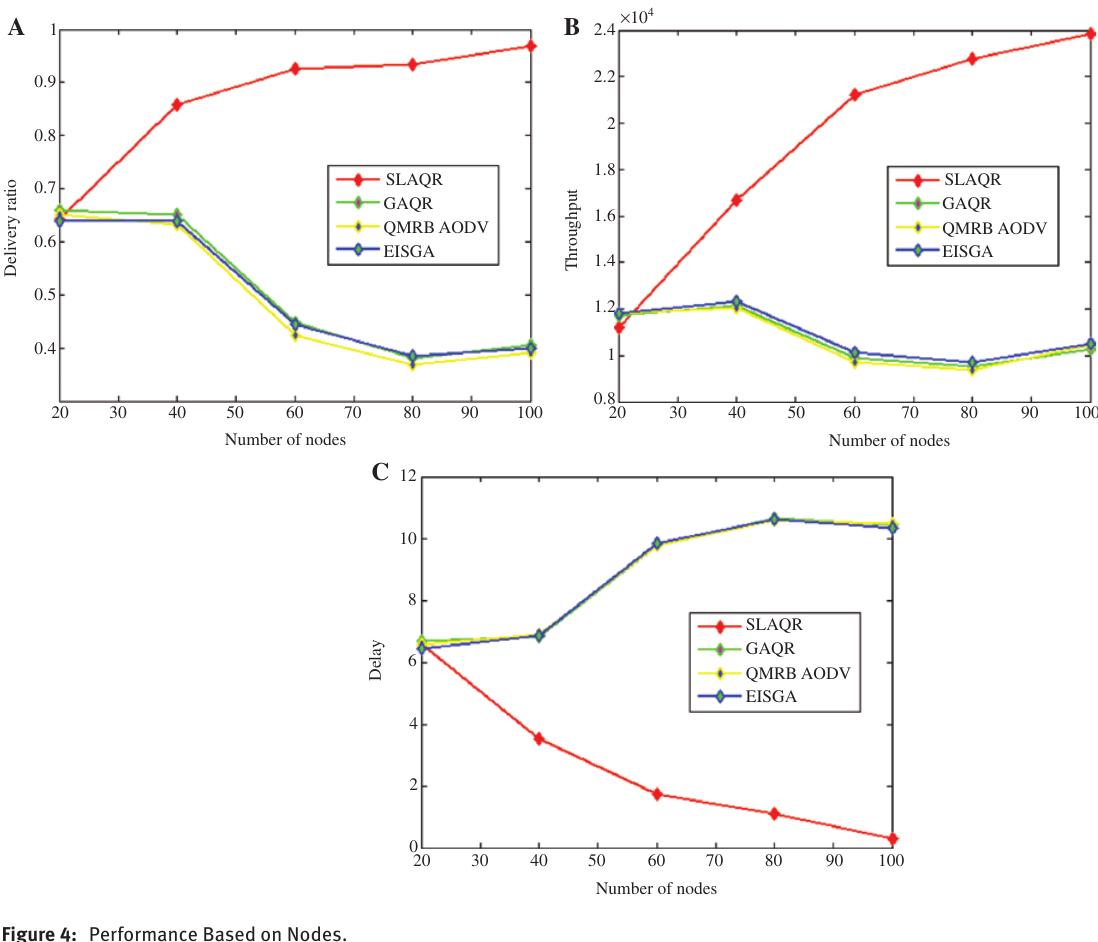
Figure 4: Performance Based on Nodes. (A) Delivery ratio. (B) Throughput. (C)